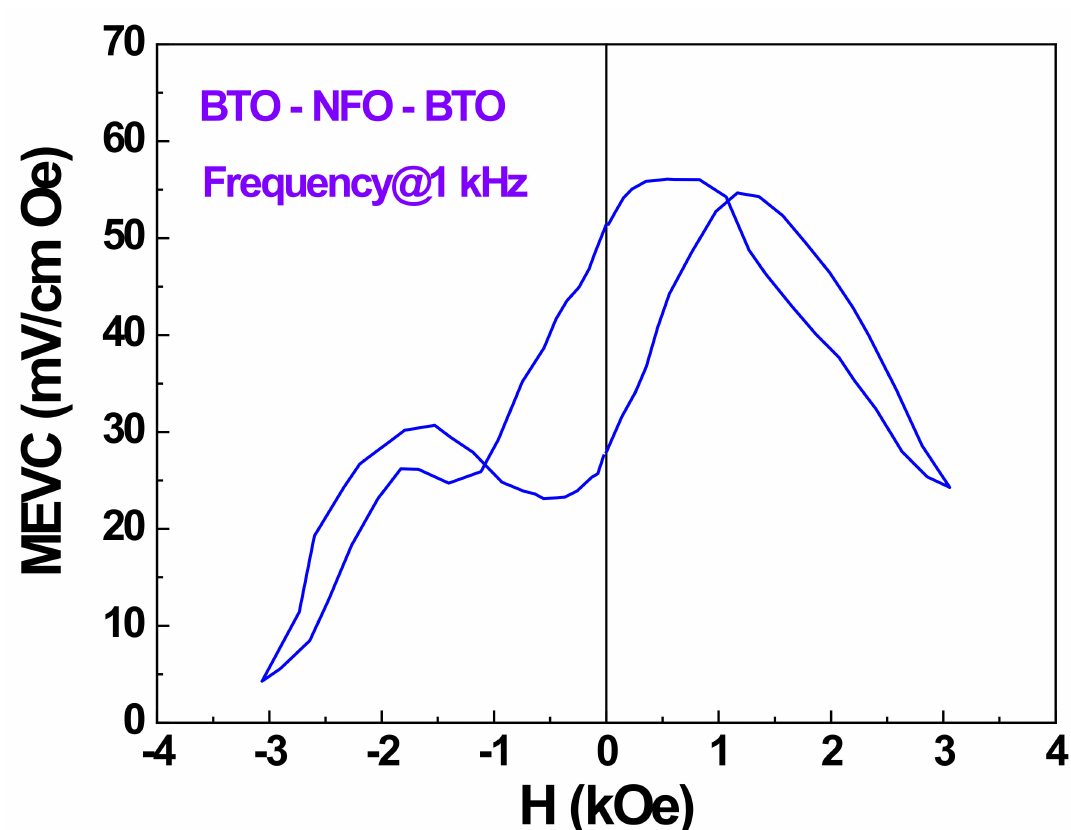
Figure 8. Magnetoelectric (ME) effect in tri-layered BTO/NFO/BTO thin films. Despite the observed ME coupling coefficient ( α E) ~54.5 mV/cm Oe, in our BTO/ NFO/BTO tri-layer thin film, is significantly higher than NFO/BTO epitaxial bilayer het- ero structures(12.1 mV/cmOe), BTO/NFO/BTO tri-layers (32 mV/cmOe) and BTO/NFO/ BTO/NFO/BTO penta layers (36 mV/cmOe), Pb(Zr 0.4 Ti 0.6 )O 3 –Ni 0.8 Zn 0.2 Fe 2 O 4